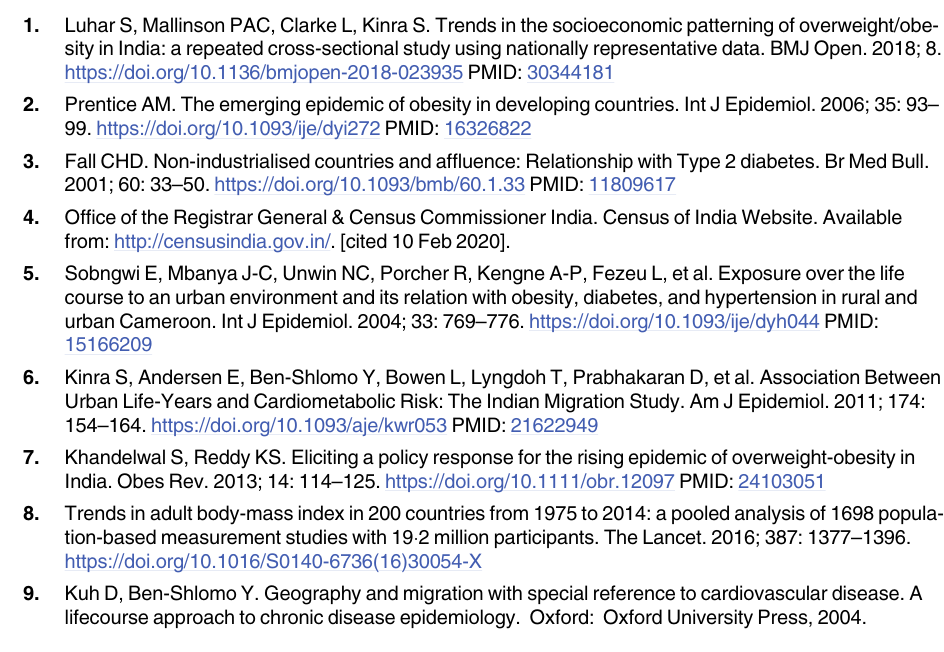
S5 Table. Multivariable model for selected diet and physical activity behaviours, stratified by